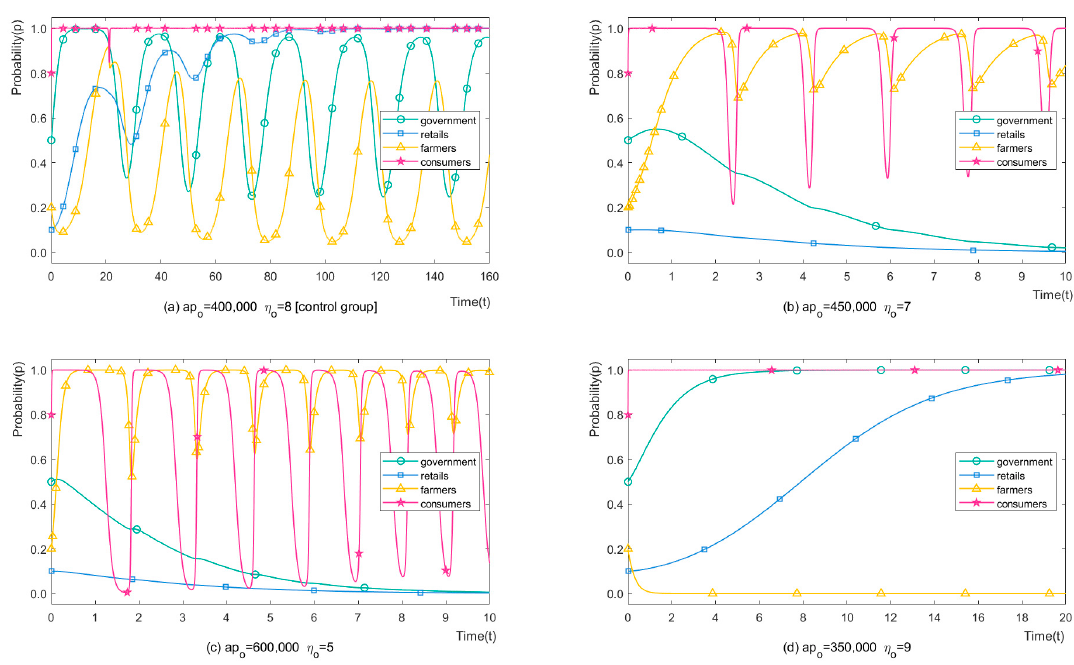
Figure 8. The strategy evolution process of stakeholders with different ap o and η o